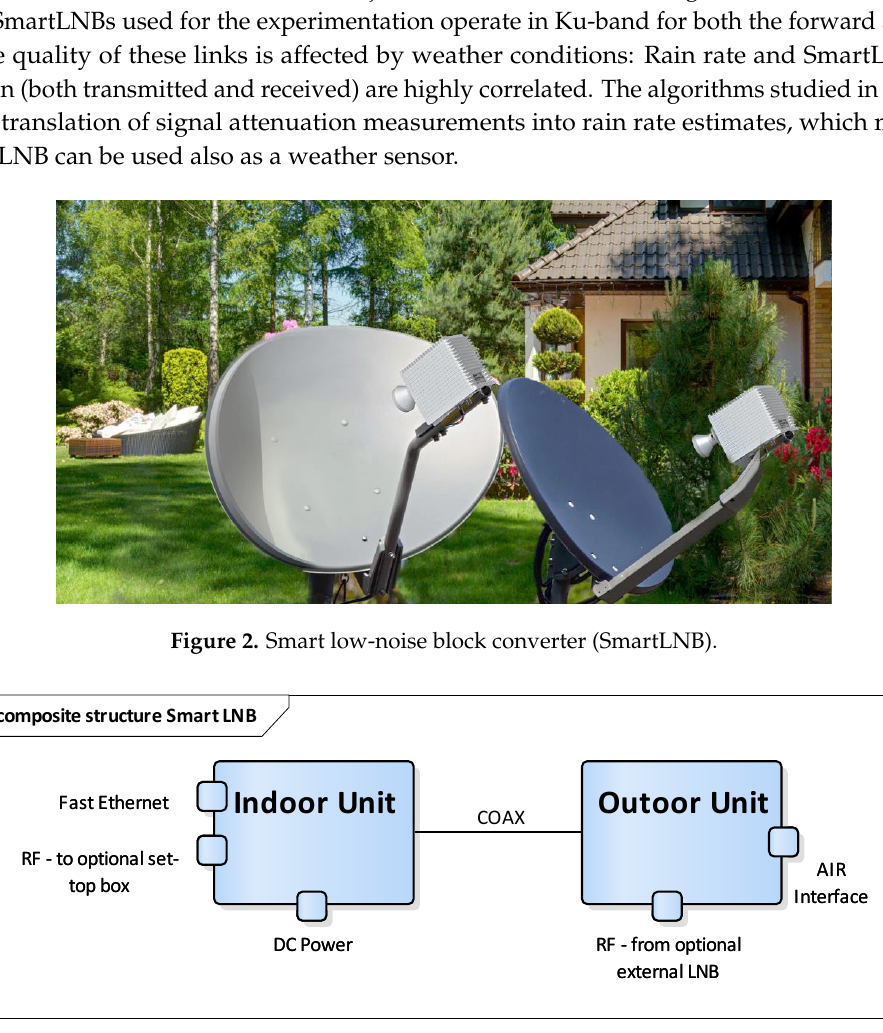
Figure 3. Architecture of the SmartLNB.